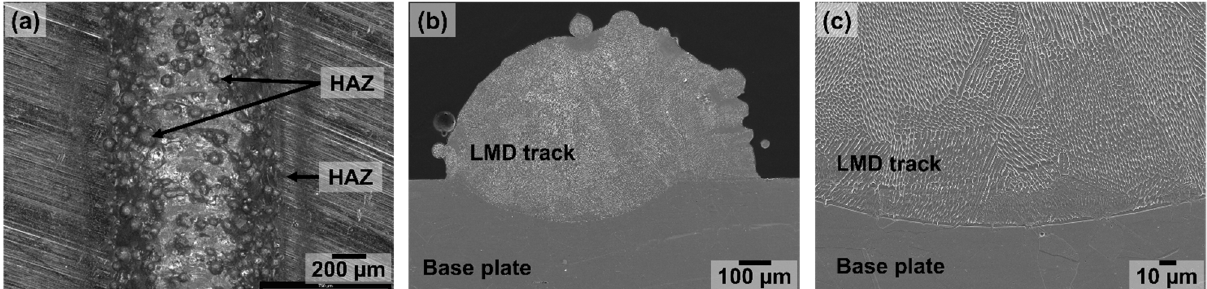
Figure 3. ( a ) Optical image of the top view of a typical printed clad in which partially un-melted powder particles and the heat-affected zone (HAZ) can be seen. Secondary electron images of ( b ) the cross section of a typical printed clad, and ( c ) high resolution image of a region around the interface between the printed clad and the base plate.